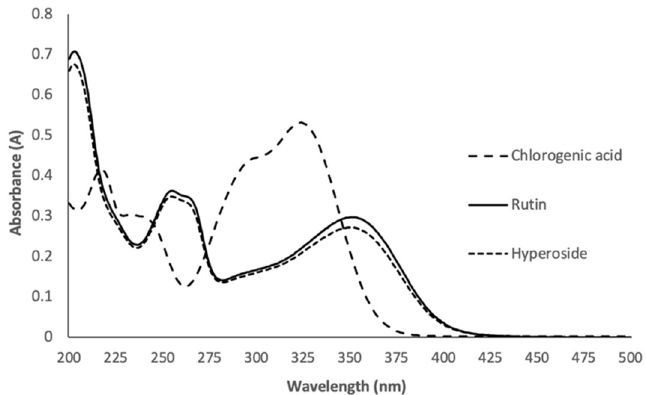
Figure A1. Standard solution of chlorogenic acid, rutin, and hyperoside (1 mg/mL methanol) diluted 1:100 v / v with distilled water and analyzed between 200 and 500 nm.